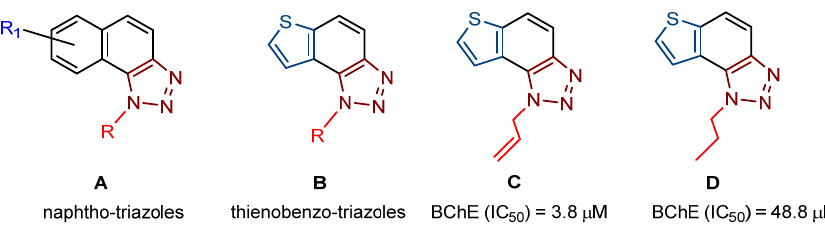
Figure 1. Previously investigated thienobenzo/naphtho-triazoles ( A – D ) with cholinesterase inhibitory activity.